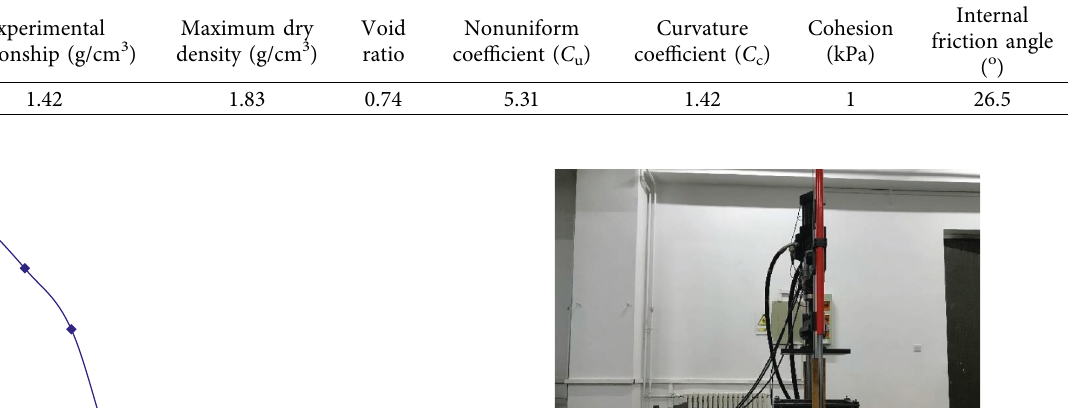
Table 2: The physical and mechanical indexes of soil.